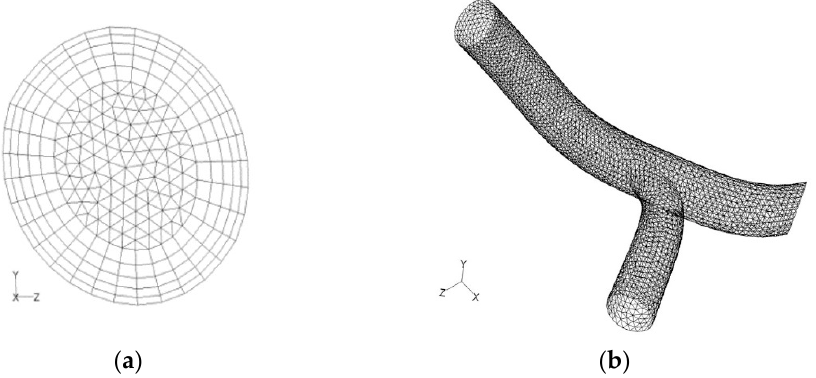
Figure 4. Three-dimensional view of imaging rendering ( a ) and real iliac bifurcation model geometry ( b ).